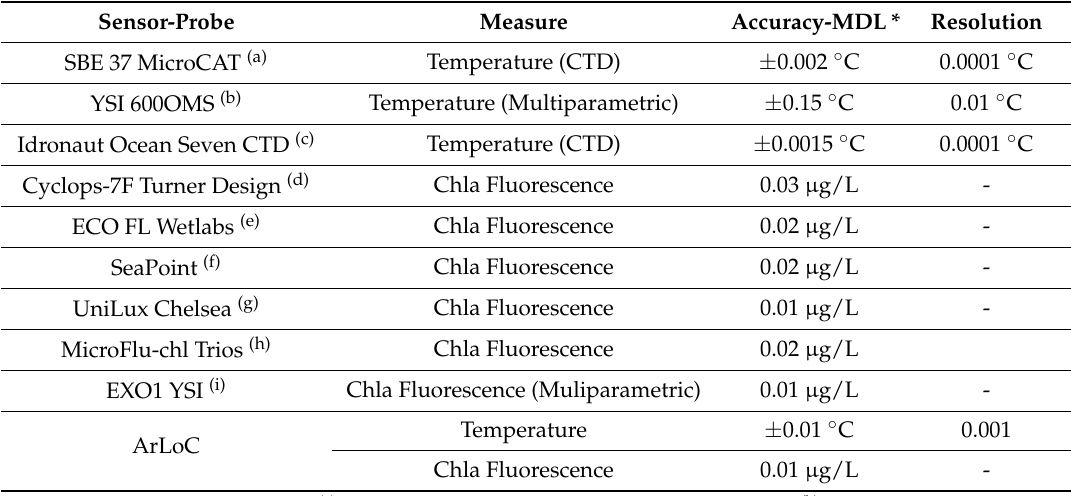
Table 1. Main specifications of commercial marine sensors and probes.